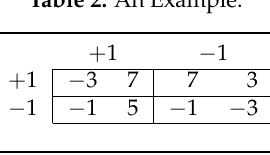
Table 2. An Example.